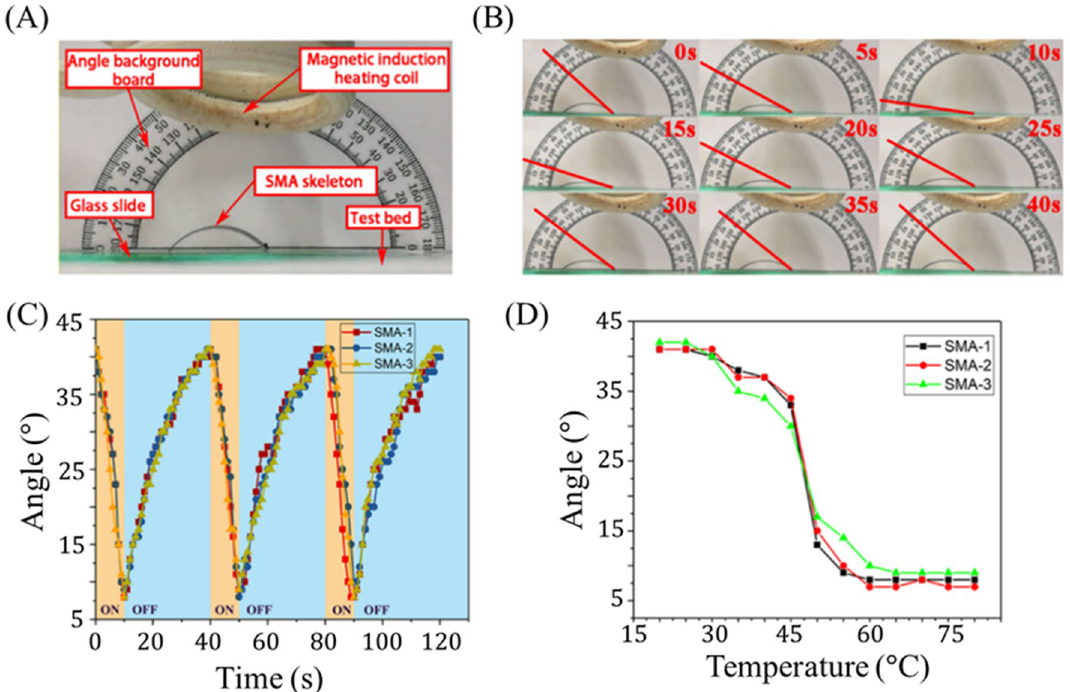
Figure 2. Magnetothermal deformation response of SMA actuator. ( A ) The experimental setup used to measure magnetothermal response of the SMA strip is shown. ( B ) One cycle of periodic deformation is displayed, with the tangent angle used to characterize deformation denoted by a red line. ( C ) Deformation angle is plotted with respect to time for three SMA skeletons undergoing three periods of reversible loading (each). ( D ) Deformation angle is plotted with respect to temperature of the SMA